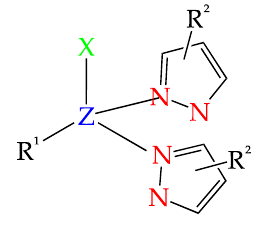
Figure 1. General scorpionate structure: poly(pyrazol ‐ 1 ‐ yl)borates for Z = B; poly(pyrazol ‐ 1 ‐ yl)methanes for Z = C.